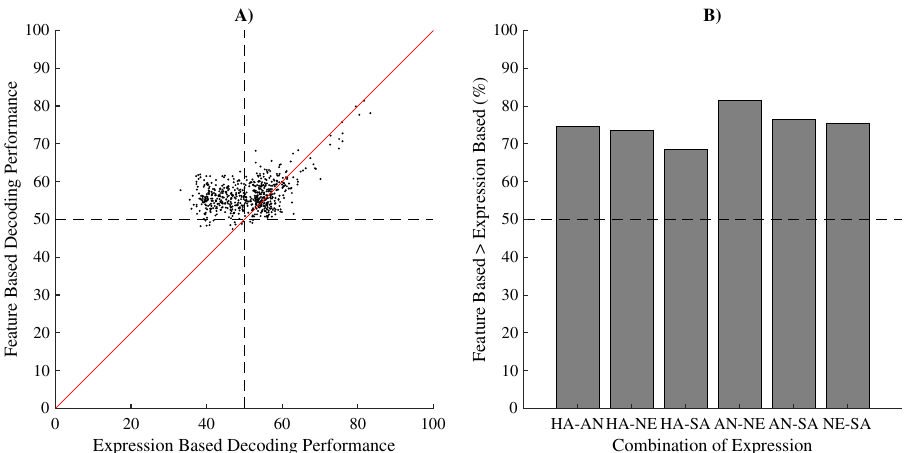
Figure 8. ( A ) Relation between the average percentage correct prediction for each participant and each combination of emotions based on the biases towards expressions (x-axis) and the average corresponding percentage correct prediction based on the low-level image features of the images (y-axis). The dotted vertical line represents chance level performance for emotion-based decoding. The dotted horizontal line represents chance level performance for low-level image features-based decoding. The solid diagonal line shows where performance would be equal. ( B ) For each combination of emotions separately, the percentage of the predictions where low-level image features-based prediction out-performed prediction based on biases towards emotions. Note that for all emotions this is the case (all values well above